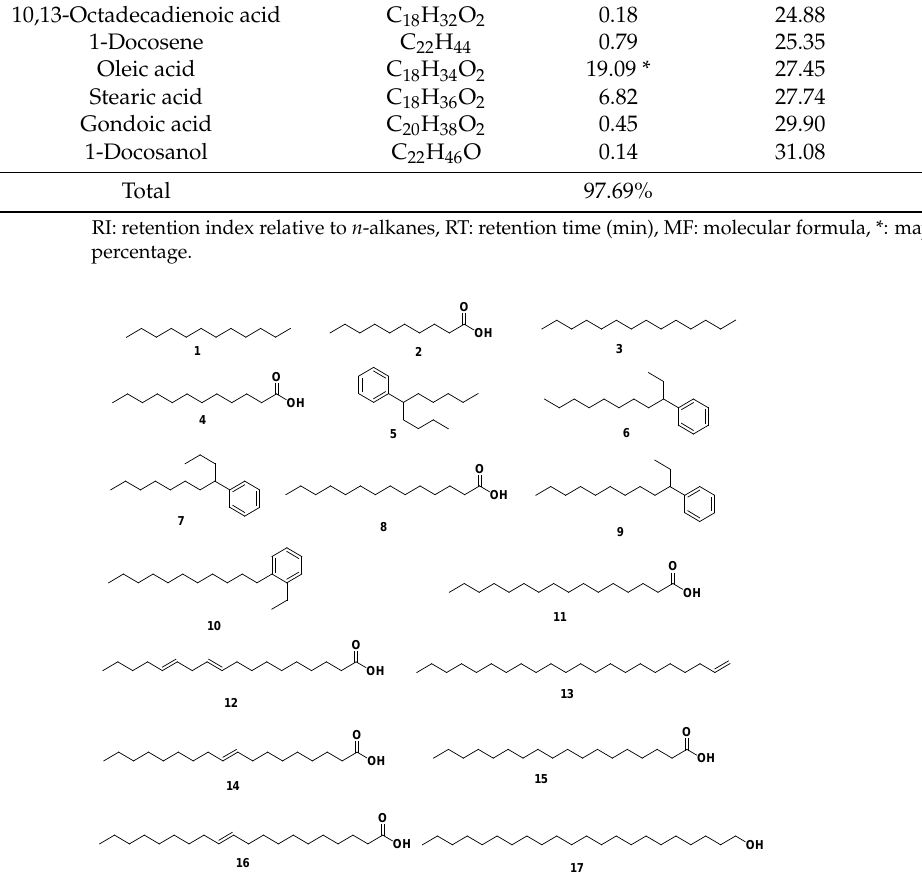
Figure 2. Structures of identified compounds from coconut seed oil by GC/MS analysis.